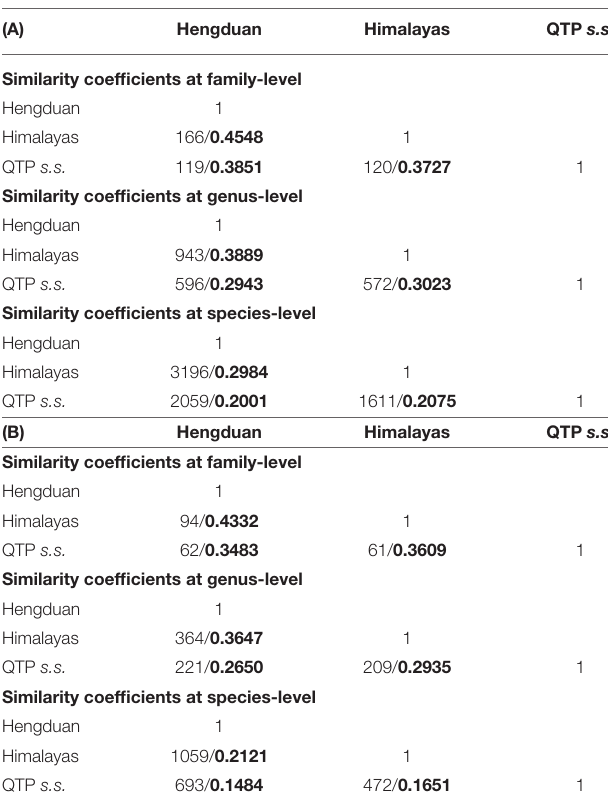
TABLE 2 | Similarity coefficients of floristic composition between the Hengduan Mountains, the Himalayas, and the Qinghai-Tibet Plateau s.s. at the family, genus and species